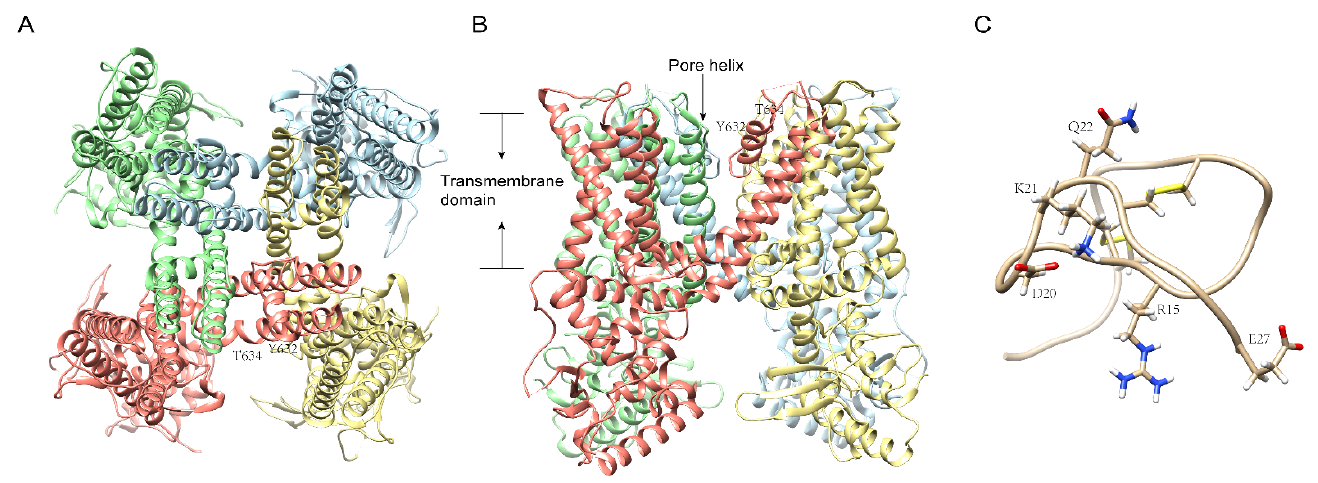
Figure 4. The cryo-electron microscopy structure of TRPV1 and RhTx. Ribbon diagram of TRPV1 atomic model (PDB id: 7L2L) with each of the four identical subunits color-coded, showing views from the bottom ( A ) and side ( B ). The key residues for the interaction with RhTx are labeled. The membrane-spanning helices and different subunits of the TRPV1 channel are indicated. ( C ): RhTx from Scolopendra subspinipes . PDB id: 2MVA.